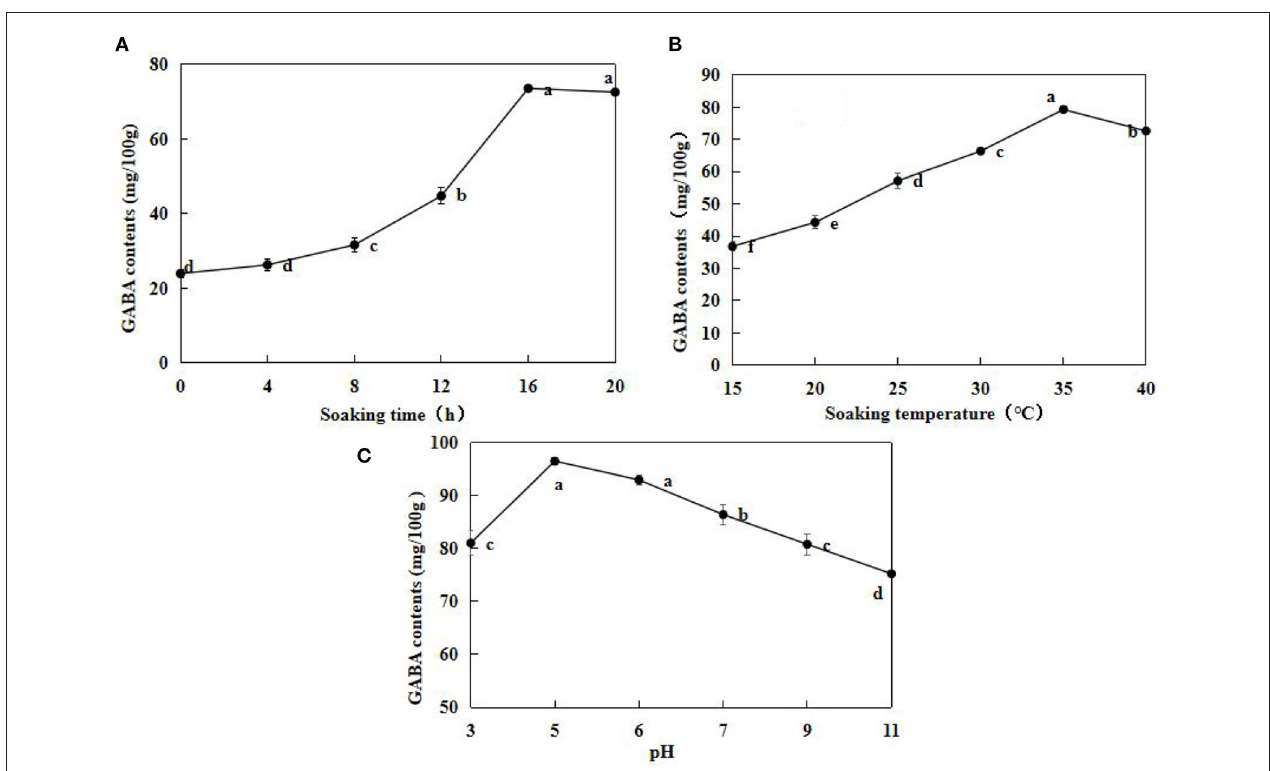
FIGURE 1 | Effects of soaking time (A) , soaking temperature (B) , and pH (C) on adzuki bean GABA contents. The soaking temperature was fixed at 25 ◦ C, and the soaking times were 0, 4, 8, 12, 16, and 20h (A) ; The adzuki beans were soaked in distilled water at 15, 20, 25, 30, and 35 ◦ C for 12h (B) ; Soaking temperature was 25 ◦ C for 12h, soaking buffer pH values were 3, 5, 6, 7, 9, and 11. Subsequently, GABA contents in the samples under different conditions were determined. Data are mean ± SD ( n = 3). Different lowercase letters indicated significant difference at p <